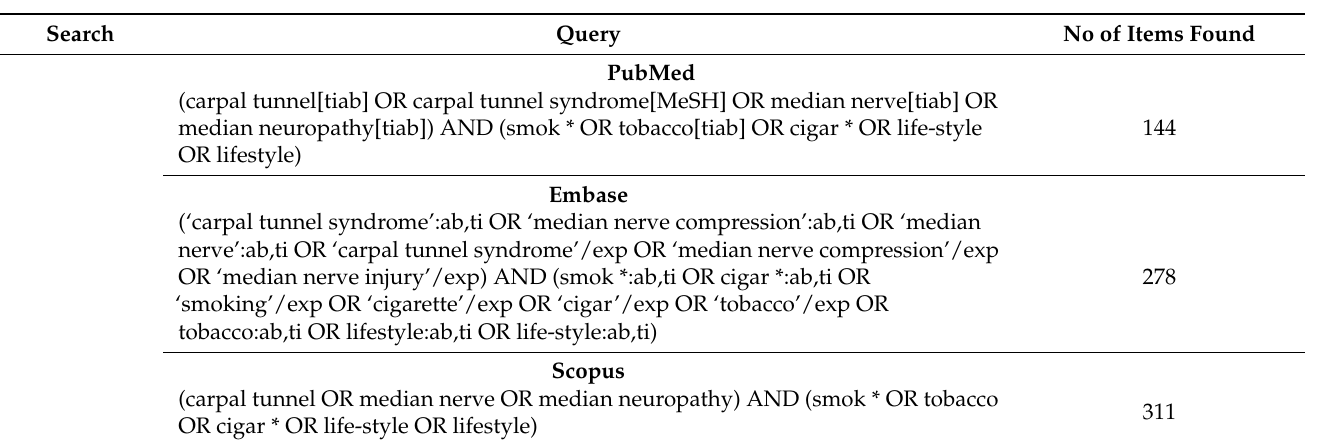
Table 1. PubMed, Embase, and Scopus searches, conducted on 2 October